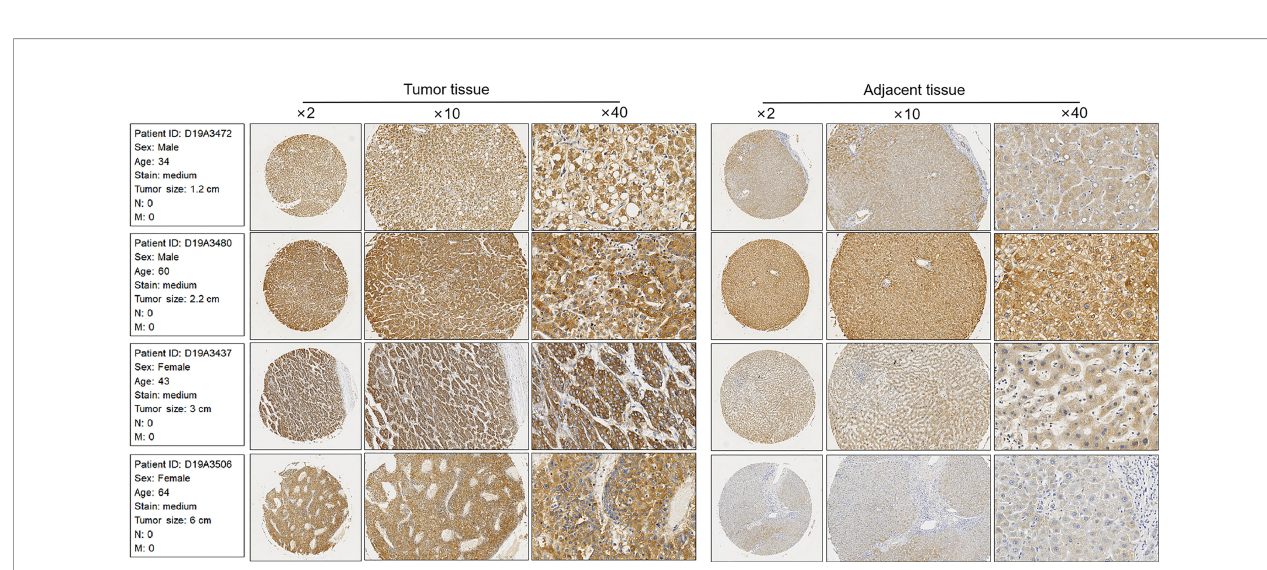
FIGURE 2 | CCDC88A was positively correlated with VEGFA in LIHC. To analyze the correlation between CCDC88A and VEGFA, the GEPIA database was employed and the scatter plots show Pearson ’ s correlation of CCDC88A expression with expression of VEGFA. (A) The correlation between CCDC88A and VEGFA in LIHC, COAD, and LUAD was analyzed. (B) The correlation between CCDC88A and VEGFB or VEGFC in LIHC was analyzed.